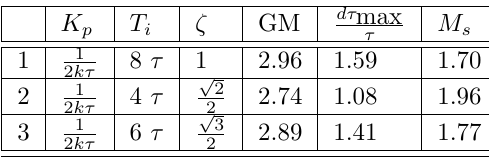
Table 1: PI-controller settings for an integrating plus time delay system, h p ( s ) = k e − τs , with gain s velocity, k , and time delay τ ≥ 0. Setting 1 is the Skogestad IMC (SIMC) setting. Set- tings 2 are suggested by Haugen (2010) and settings 3 are proposed in this paper. Differ- ent settings for the relative damping factor, ζ , used in eq. (29), and maximum time delay error, dτ max, to time delay, τ , ratio, are illus- trated. The corresponding gain Margins GM, and sensitivity indices M s , are also